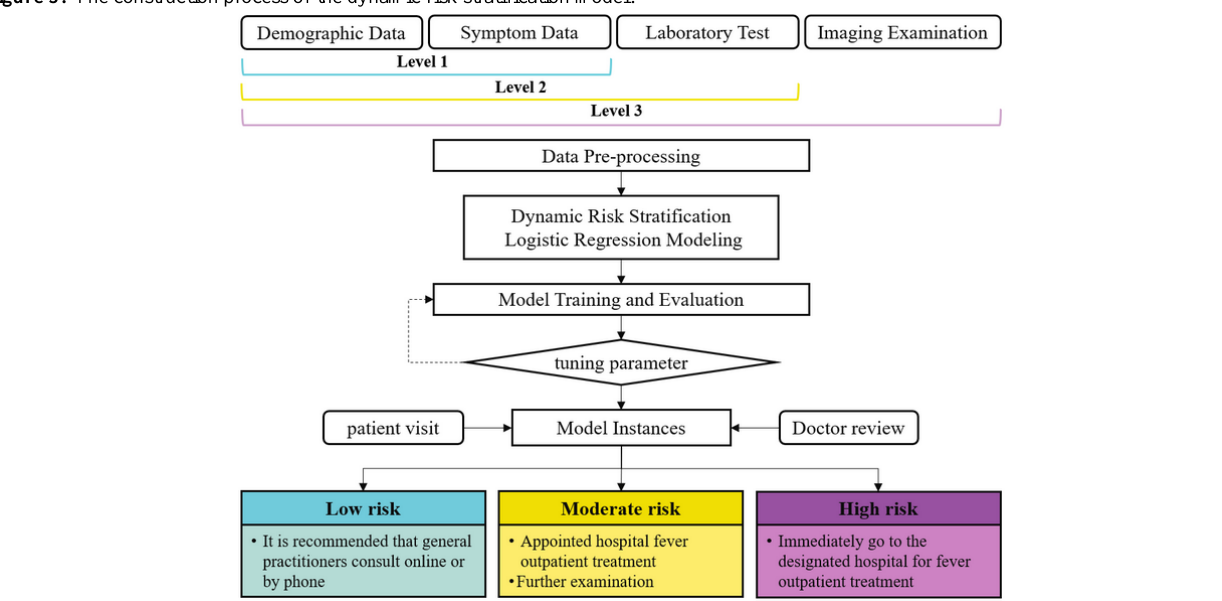
stratification model and their corresponding detailed descriptions. Data elements mainly include four categories: demographic data, epidemiological history, clinical symptoms (eg, fever, cough), the data of laboratory tests (eg, blood routine